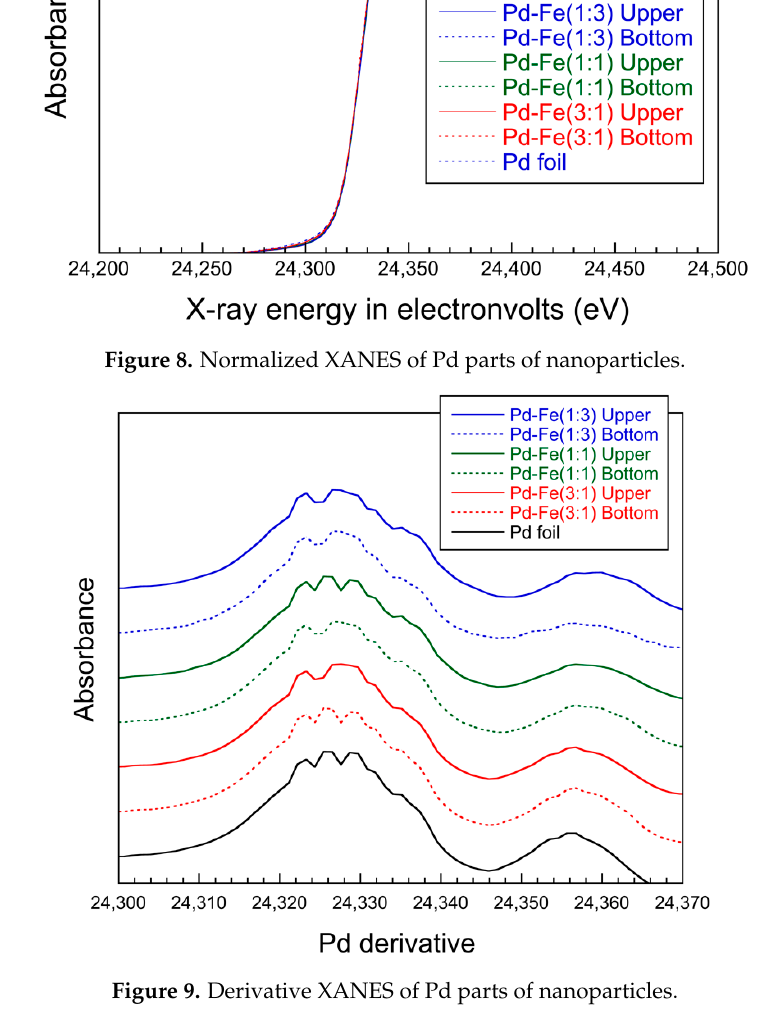
Figure 9. Derivative XANES of Pd parts of nanoparticles.